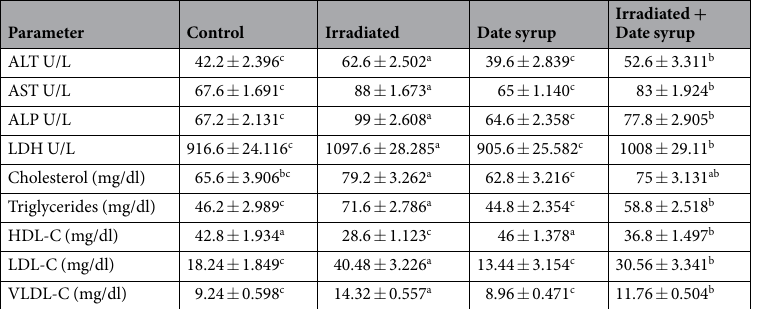
Table 1. Blood biochemical parameters in irradiated rats with or without administration of Date syrup. Values are presented as mean ± SE. Means in the same row followed by different letter superscripts are significantly different at (P < 0.05).